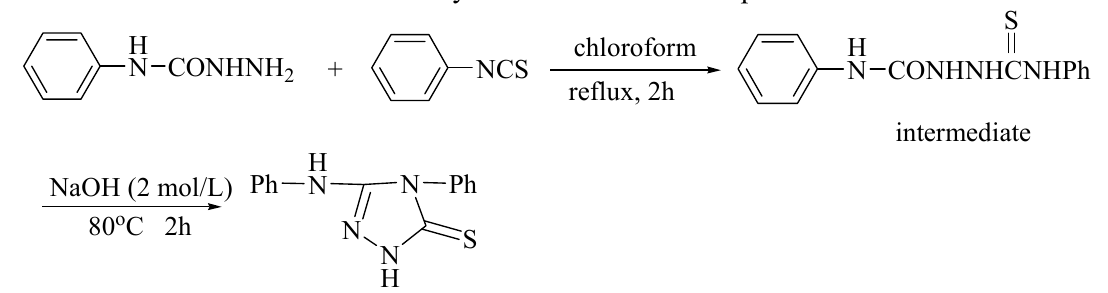
Scheme 1 . Synthesis of the title